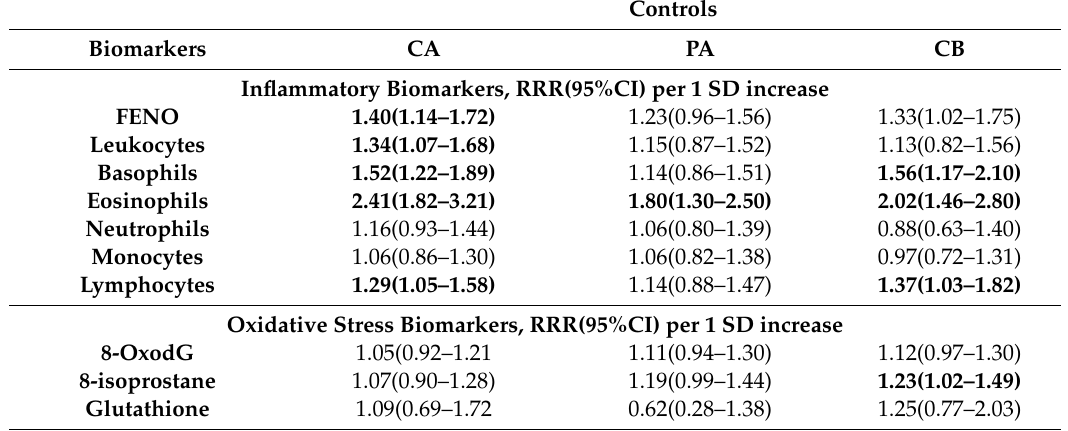
Table 3. Multivariable regression estimates of current asthma (CA), past asthma (PA) and chronic bronchitis (CB) in association with biomarkers. Non-hierarchical classification. Non-Hierarchically Classified (Separate) Respiratory Diseases